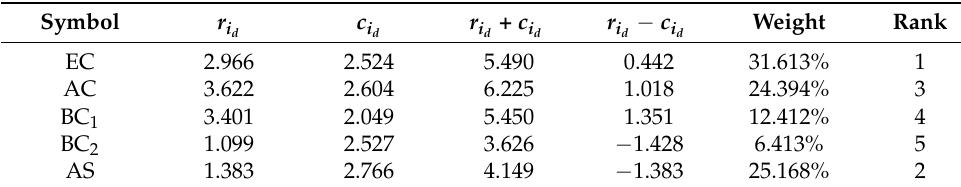
− c Table 10. r i i d weight and ranking versus each aspect. d